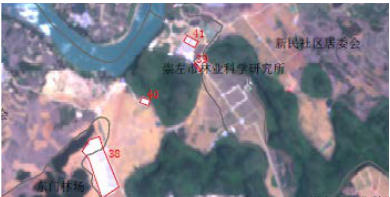
Figure 6. Issued map with suspicious illegal land utilization spot in 1:10000 (red rectangle are suspicious illegal land use spots)